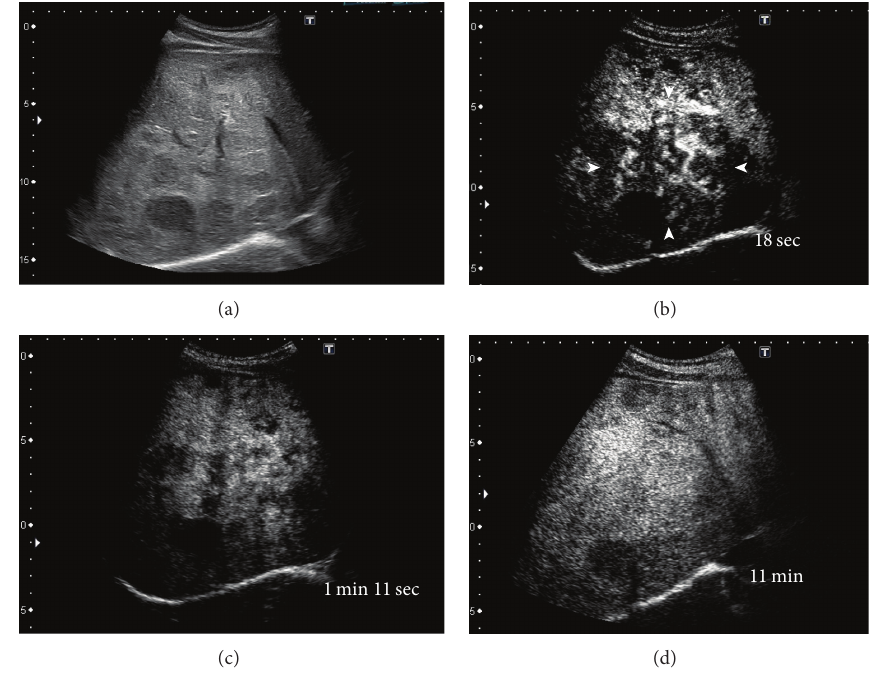
Figure 2: Ultrasonography (US) scan. (a) B-mode US scan shows a huge nonhomogeneously hypoechoic lesion in the right lobe of the liver. (b) Sonazoid contrast-enhanced US in the early vascular phase reveals “cotton wool-like pooling” (arrowhead). (c) Gradual fill-in through the late vascular phase. (d) The fill-in was completed in the Kupffer